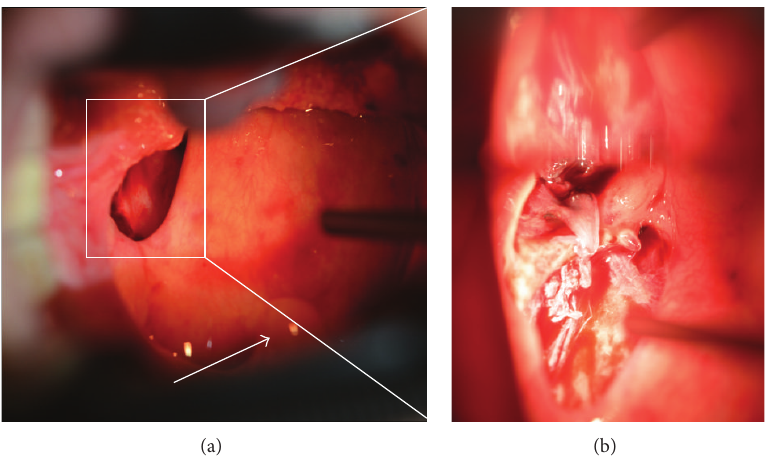
Figure 3: Intraoperative macroscopic findings of the left lateral and posterior walls of the oropharynx. Note that the left sides of the figures indicate the lateral side, lower cranial, since these photographs are taken through oral specula for tonsillectomy. (a) Inset shows the ulcerated area. Arrow indicates the uvula. (b) An enlarged view of the ulcer. The coagulated material and necrotic tissue are removed. No pus or tumorous lesions are noted.